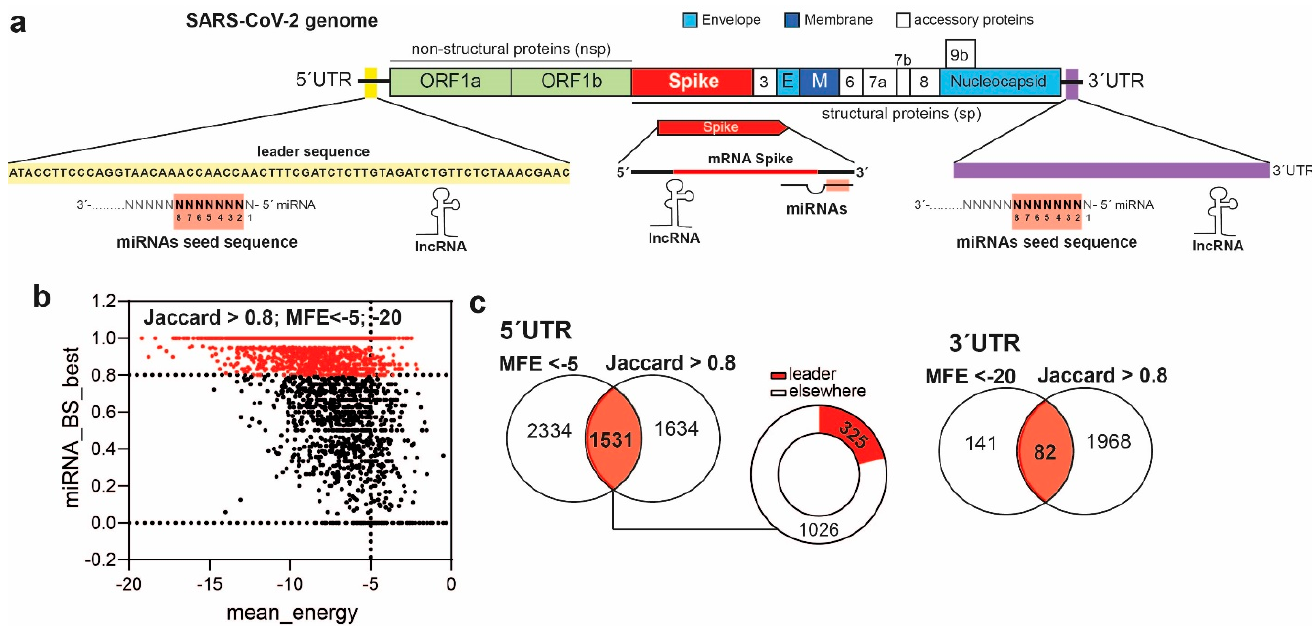
Figure 1. SARS-CoV-2 genomic sequence and miRNA binding sites (BS) identified within the 5 ′ UTR and 3 ′ UTR of SARS- CoV-2 genome. ( a ) Structural representation of SARS-CoV-2 genome with highlighted leader sequence (yellow), 3 ′ UTR (violet), and spike transcript (red) against which we identified ( b ) miRNA BS using 3 RNA:RNA prediction algorithms. Only binding sites with a Jaccard index ≥ 0.8 and a minimum free energy (MFE) < − 5 (for the 5 ′ UTR), or < − 20 (for the 3 ′ UTR of viral-RNA and Spike transcript) were considered. Bars: MiRNA_BS_best indicates the Jaccard Index scale, whereas the mean_energy scale bar indicates the MFE. Dashed lines represent the thresholds. ( c ) Representation of miRNA BS identified at the viral 5 ′ UTR, 325 of which were in the leader sequence, and 82 at the 3 ′ UTR.